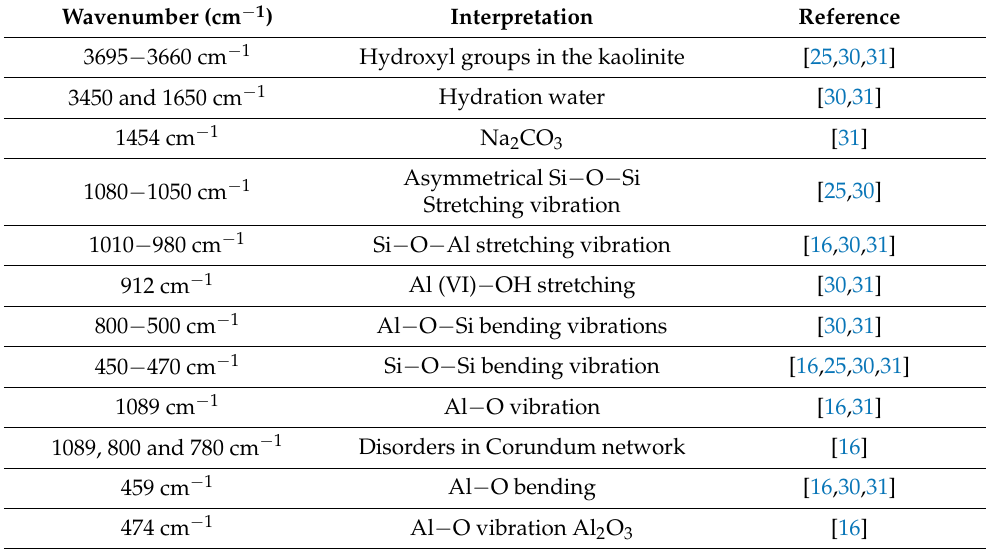
Table 2. List of vibrations of aluminosilicates and corundum in the FT-IR